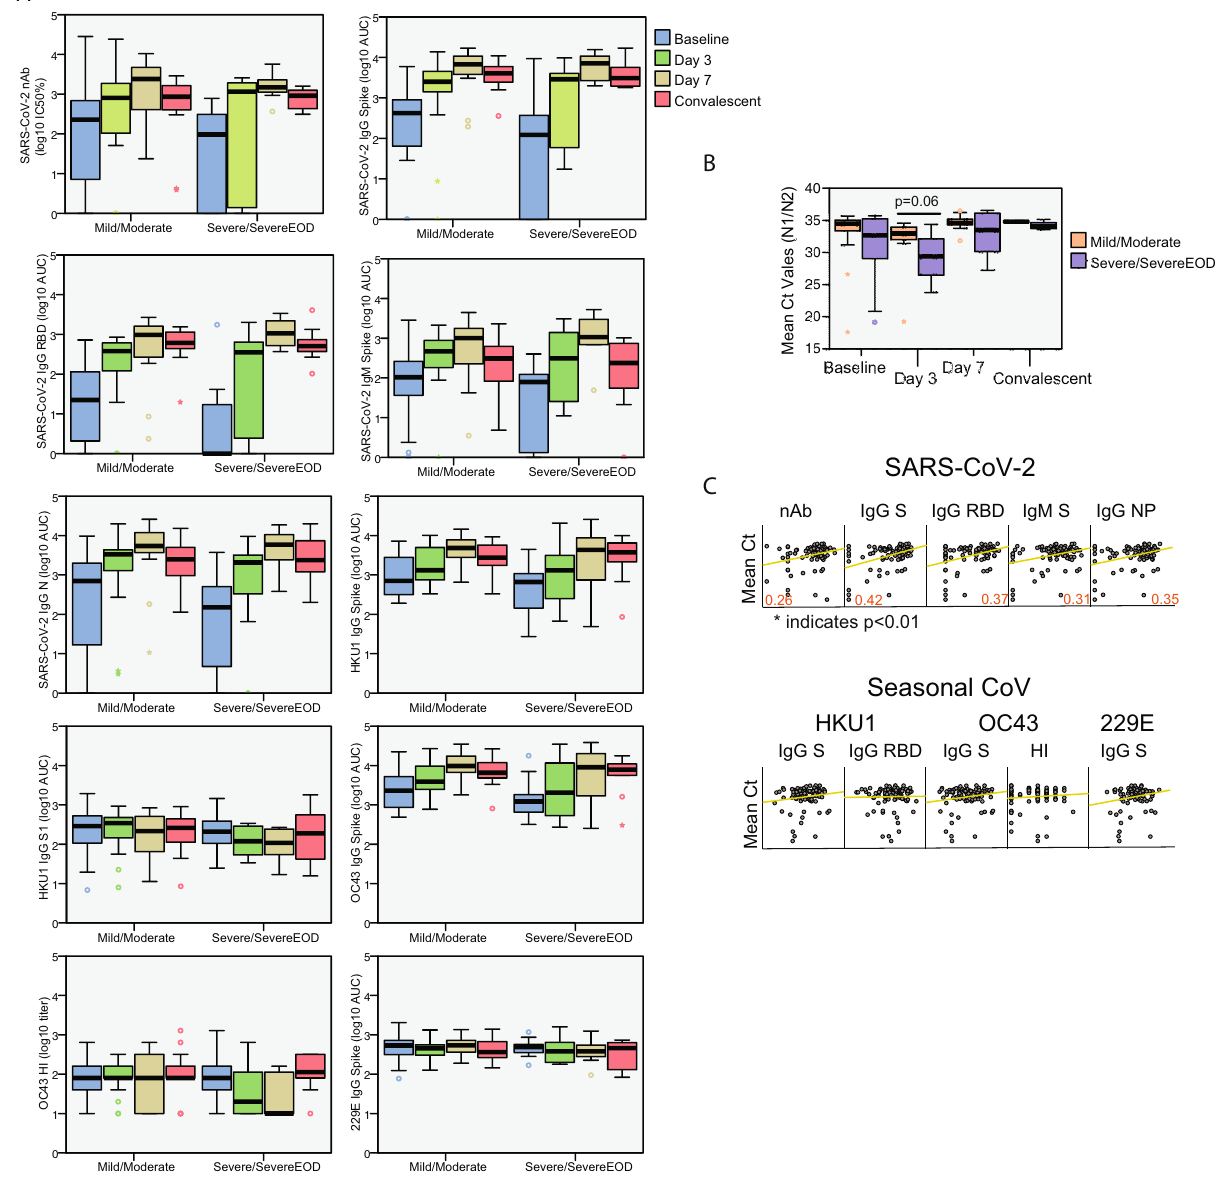
Fig. 4 Antibody response according to disease severity and viral loads in the BACO cohort. A Boxplot diagram of ELISA as area under the curve (AUC) titers against SARS-CoV-2 and endemic human coronaviruses at each time point in mild/moderate vs. severe COVID-19: IgG spike, IgG RBD, IgM spike and IgG NP; and neutralizing titer (IC50%); and HKU1 IgG spike, HKU1 IgG S1 subunit, OC43 IgG spike and 229E IgG spike; and OC43 hemagglutination titers. Black bar indicated median values, box indicates IQR (Q1 – Q3), and lines indicate minimum and maximum. Outliers from the observed distribution are shown when present in each case. Total n = 116 biologically independent serum samples (day 0 = 37, day 3 = 29, day 7 = 22, day 46 = 28). n = 116 biological samples examined against eight different SARS-CoV-2 and seasonal coronavirus substrates for ELISA assays; ELISAs for each substrate were run once each. N = 116 serum samples examined over two independent experiments for neutralization and hemagglutination assays. B Boxplot diagram of mean threshold cycle (Ct) values in mild/moderate vs. severe COVID-19 during the follow-up. N protein was detected by RT-qPCR. Black bars indicate median values, the box indicates IQR (Q1 – Q3), and lines indicate minimum and maximum. Outliers from the observed distribution are shown when present in each case. Total n = 93 biologically independent nasopharyngeal swab (day 0 = 37, day 3 = 28, day 7 = 22, day 46 = 6). n = 93 biological samples examined against two different SARS-CoV-2 primers over two independent experiments each. Mann – Whitney U test for independent samples was performed. Reported p values are based on two ‐ tailed tests. C Scatterplot of the relationship between measured SARS-CoV-2 and seasonal coronaviruses antibody responses and Ct values in the COVID-19 patients. Pearson coef fi cient of statistically signi fi cant correlations is indicated in red. Matrix axis are log10 values scaled from 0 to 4. Total n = 93 biologically independent nasopharyngeal (NP) swab and 93 paired serum samples. Pearson correlation was calculated based on matched NP and serum samples. P values for statistically signi fi cant values are shown and based on two ‐ tailed tests. Source data are provided as a Source Data